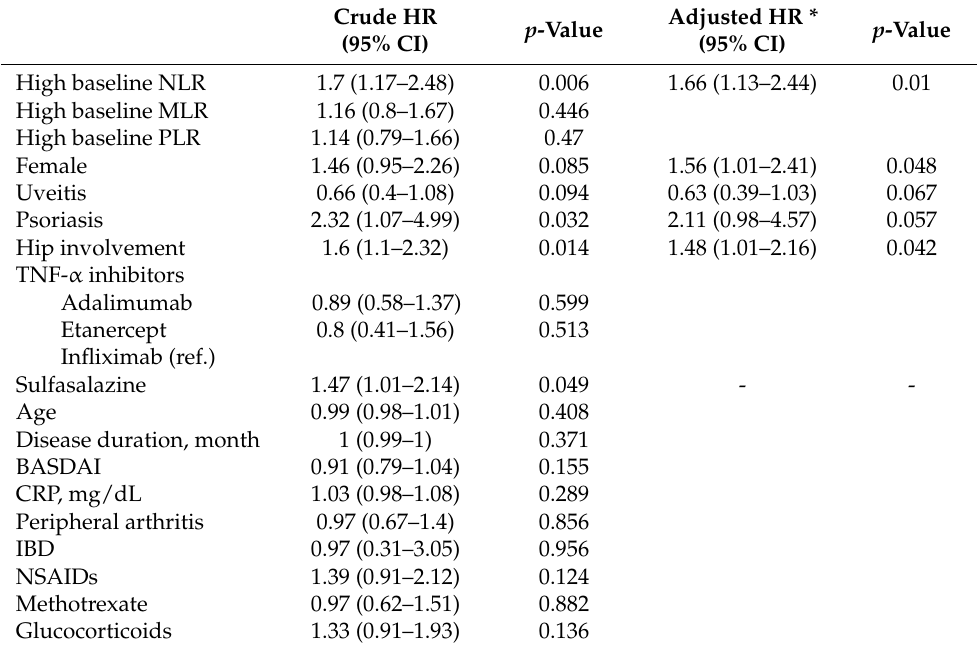
Table 4. Associated factors for drug persistence to tumor necrosis factor-alpha inhibitors in patients with ankylosing